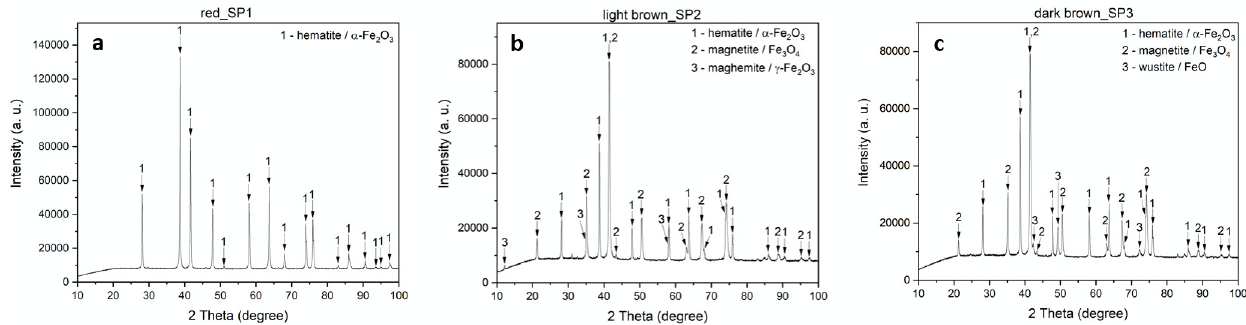
Figure 2. XRD patterns of ( a ) SP1 pigment (red color); ( b ) SP2 pigment (light brown color); and ( c ) SP3 pigment (dark brown color).